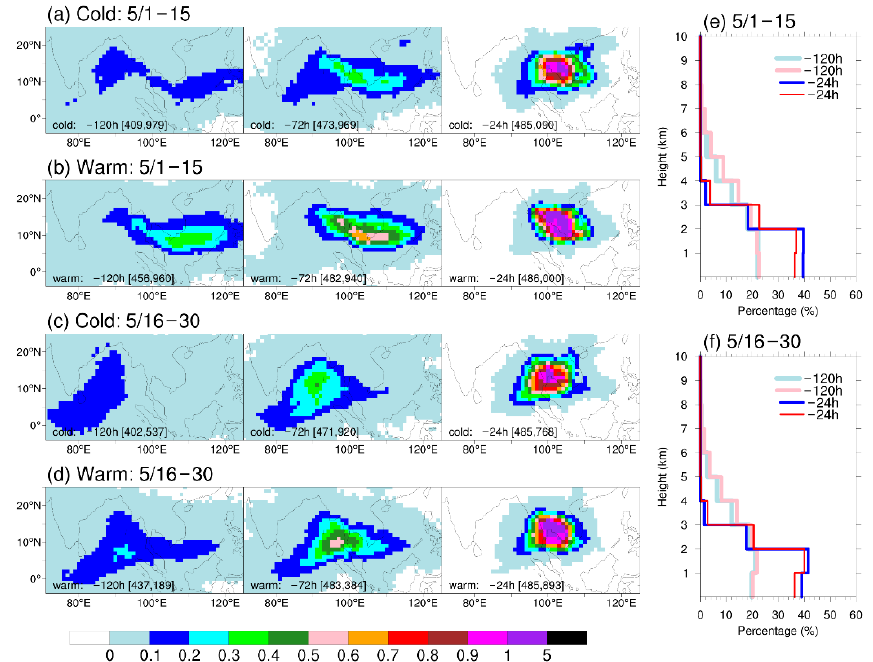
Figure 11. The density distributions of the backward trajectories from the ICP region started within a layer bounded with heights between 1000 and 2000 m above mean sea level. The horizontal distributions of the trajectory density for the 15-day periods of 1 – 15 May from the ( a ) cold and ( b ) warm years and of 16 – 30 May from the ( c ) cold and ( d ) warm years. For each 15-day period, there are 486,000 initial air parcels released and tracked, and their six-hourly horizontal positions are then binned onto a 1° × 1° latitude – longitude grid, from which the histograms are calculated. Using the histograms (count in each grid cell), the trajectory density per grid cell is computed as the percentage of the total. The density of the 120, 72, and 24 h backward trajectories are shown from left to right panels, respectively, in ( a – d ). The numbers in square brackets are the total counts of the trajectory remaining in the domain at the corresponding backward times. The vertical distributions of the trajectory density were collected in the 15-day periods of ( e ) 1 – 15 May and ( f ) 16 – 30 May. The six-hourly trajectory histograms of the horizontal positions are further binned with respect to the trajectory altitudes using 1 km increments, and the domain-wide trajectory density per 1 km increment is computed as the percentage of the total. Trajectory densities from warm and cold years are superimposed for comparison.